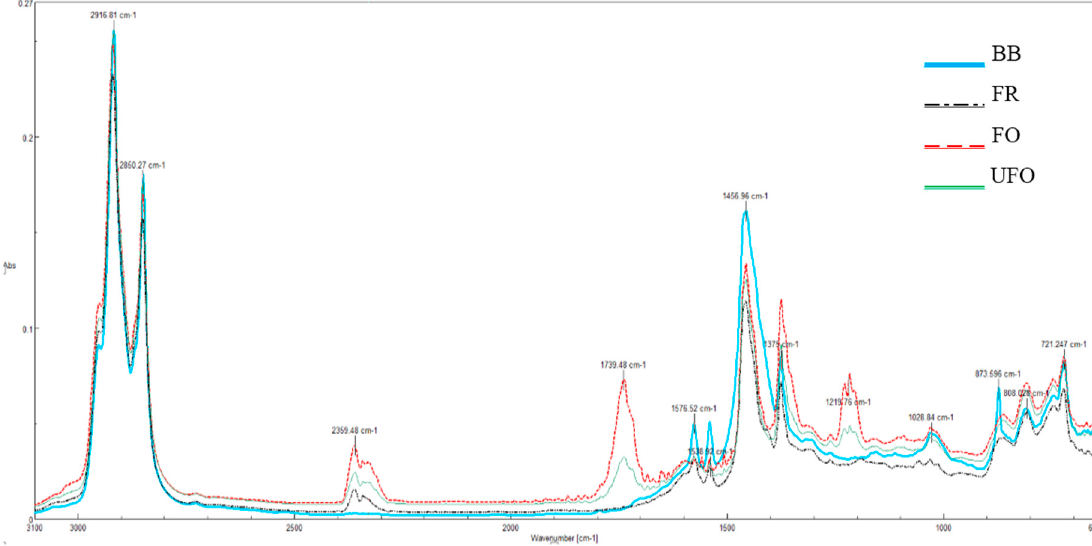
Figure 5. FTIR spectra comparison of unaged asphalt binders.